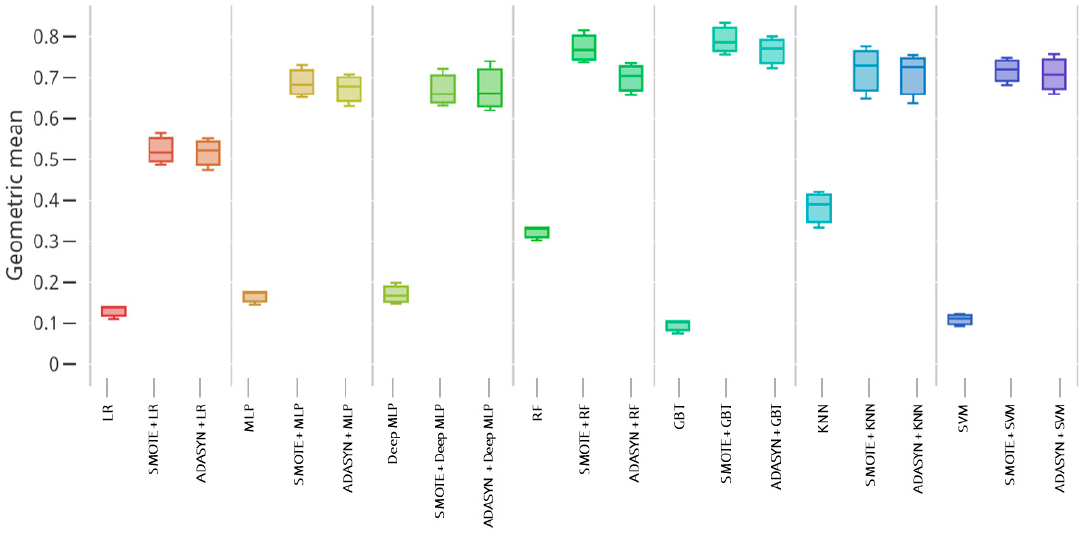
Figure 3. Boxplot of the geometric mean over prediction models among all subjects.